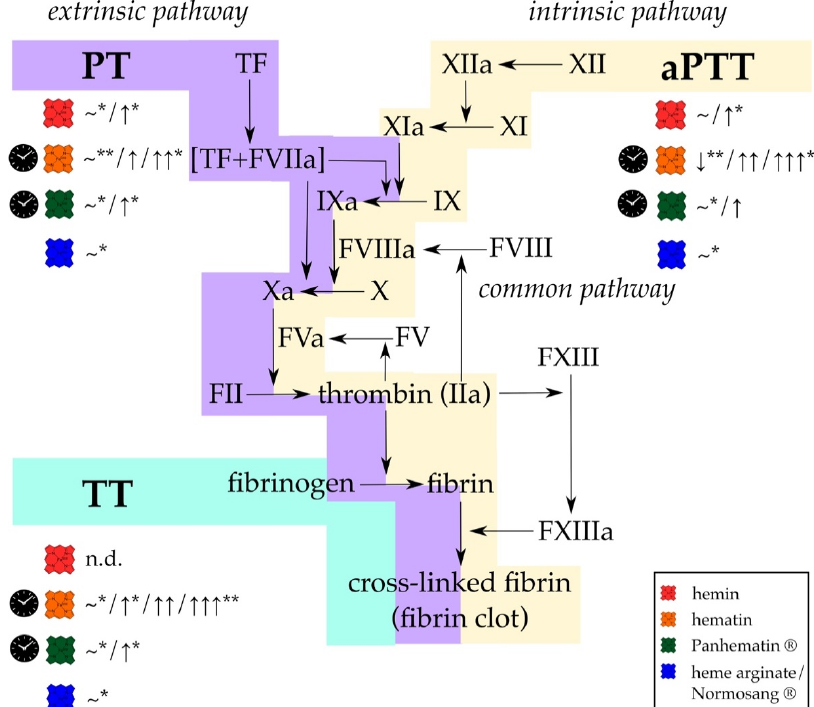
Figure 2. Different formulations of heme affect the results of standard coagulation diagnostic tests, (PT, aPTT, and TT) in vitro and in vivo. While PT is used to evaluate effects on the extrinsic and common pathway (violet), changes in the intrinsic and common pathways (yellow) can be determined using aPTT. With TT only the last step of fibrin generation and fibrin clot formation (turquoise) can be analyzed. Hemin (red symbol; concentration ranges: 50 mg/kg, 50 µ mol/kg, 0.01–100 µ M) either did not affect PT and aPTT or a slight prolongation was observed. TT was not determined (n.d.). In contrast, hematin (orange symbol; concentration ranges: 4–12 mg/kg, 3 nmol, 10–100 µ g/mL) has been reported to induce significant prolongation of all clotting times. For Panhematin ® (green symbol; concentration ranges: 4 mg/kg, 70–78 µ g/mL), longer clotting times were also recorded, but to a lesser extent than with hematin. However, from detailed investigations of different researcher it can be assumed that just aged hematin and Panhematin ® solutions can have such strong effects, whereas fresh hematin and Panhematin ® solutions are ineffective (clock symbol) [156,157,175]. Heme arginate/Normosang ® (blue symbol; concentration: 3 mg/kg) did not influence these diagnostic tests at all. FIIa = thrombin, FII = prothrombin, FV = factor V, FVa = activated factor V, FVIIa = activated factor VII, FVIII = factor VIII, FVIIIa = activated factor VIII, FIX = factor IX, FIXa = activated FIX, FX = factor X, FXa = activated FX, FXI = factor XI, FXIa = activated FXI, FXII = factor FXII, FXIIa = activated factor XII, FXIII = factor XIII, FXIIIa = activated factor XIII, n.d. = not determined, ~ = no effect, VWF = von Willebrand factor, ↓ = 30% decrease, ↑ = < 2-fold increase, ↑↑ > 2-fold increase, ↑↑↑ > 3-fold increase. * only observed in in vivo experiments; ** only observed in in vitro